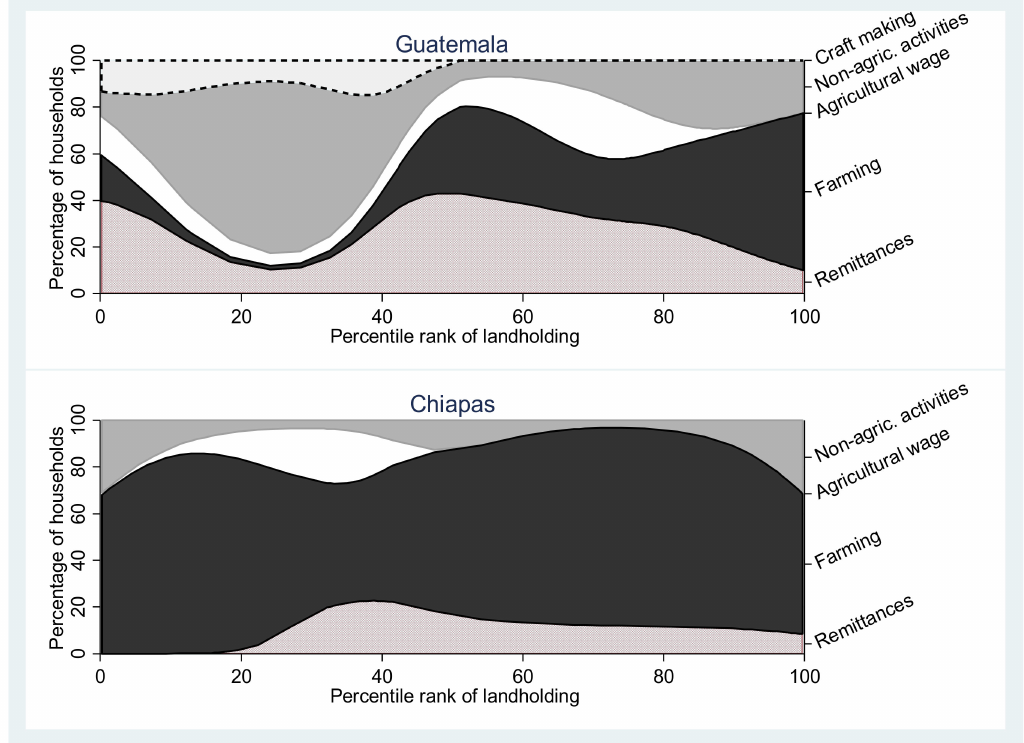
Figure 5. Landholding distribution by main income source for